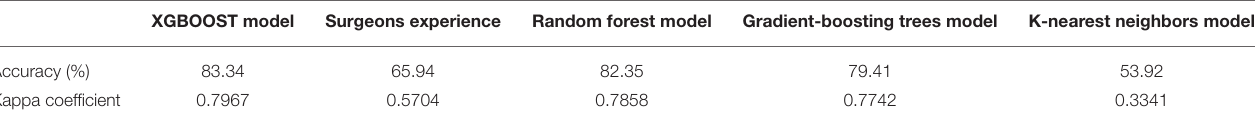
TABLE 2 | The ability of different model and surgeons experience to predict the need for perioperative red blood cells transfusion in test subset (ternary classifications). XGBOOST model Surgeons experience Random forest model Gradient-boosting trees